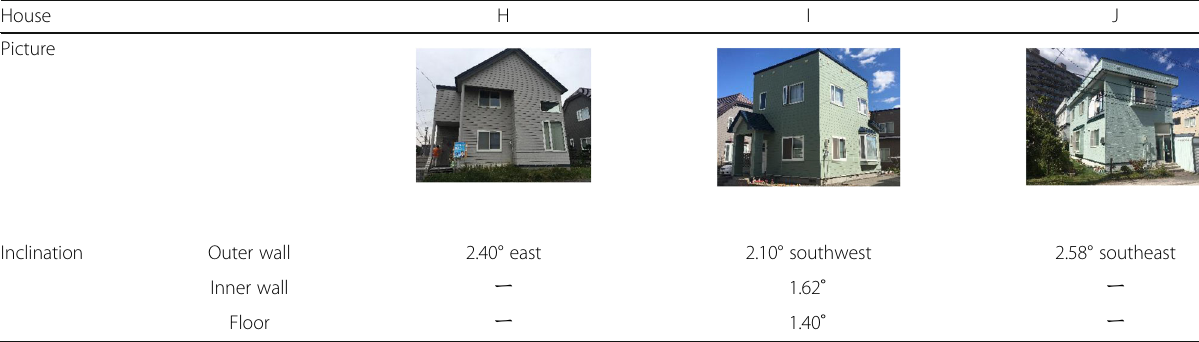
Table 4 Inclination of houses (Utsukushigaoka 3jo, H to J) House Picture